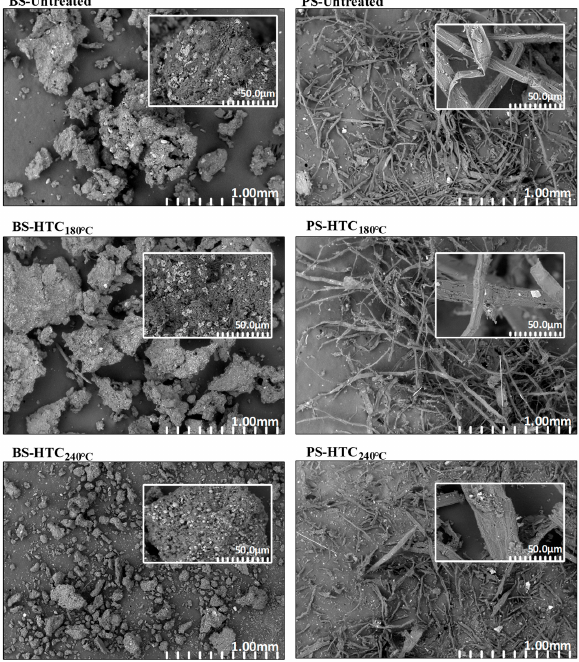
Figure 6. BSE images for the untreated and HTC180 °C and HTC240 °C of biosludge and primary sludge.